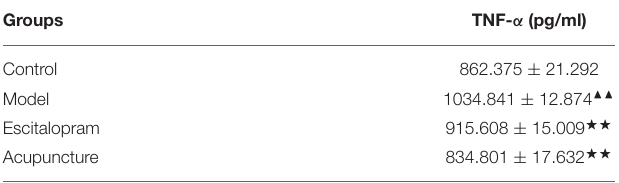
TABLE 5 | Effects of acupuncture on the content of serum TNF- α of CRS